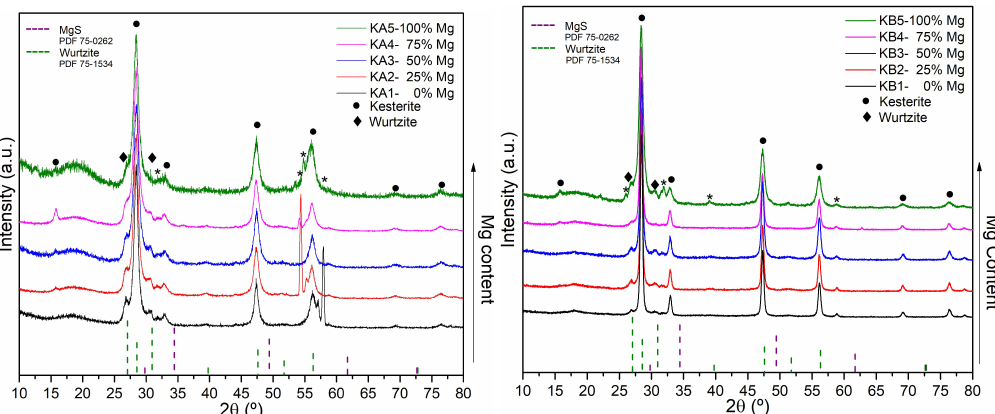
Figure 2. X-ray diffraction (XRD) patterns of the KA series ( left ) and KB series ( right ) samples. MgS and wurtzite reference data were obtained from [26,27], respectively. Secondary phases’ peaks are identified with